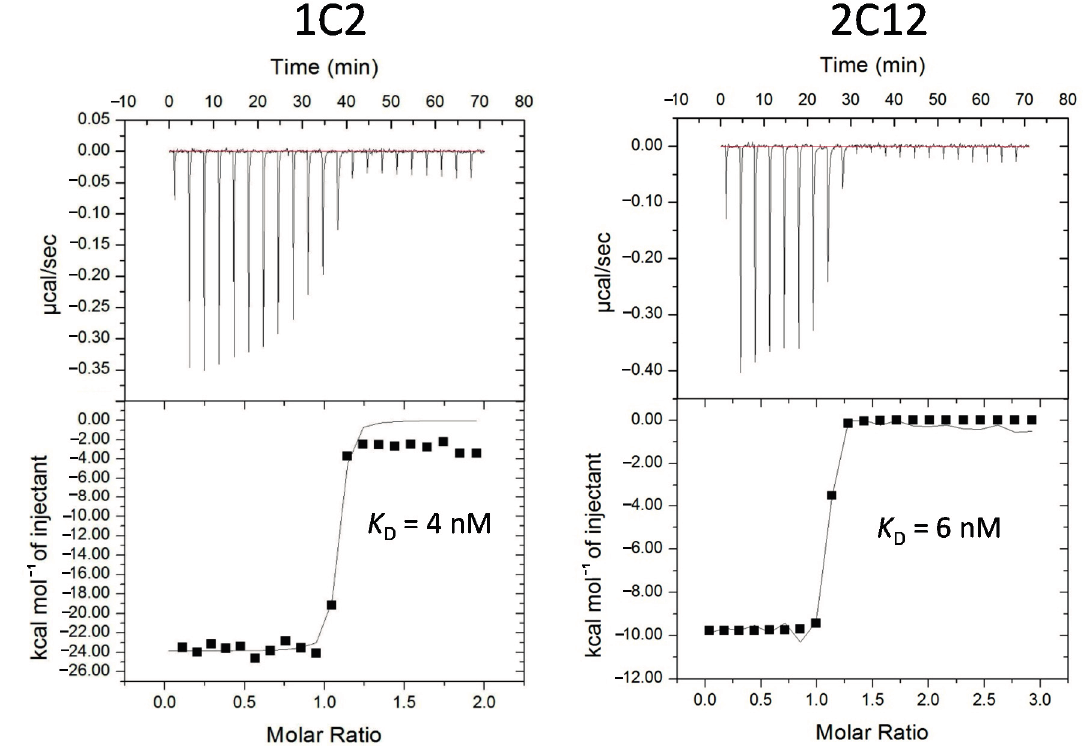
Figure 3. Determination of dissociation constant ( K D ) via isothermal titration calorimetry (ITC). Purified monobodies were injected into the sample cells loaded with their respective targets. Binding events elicited a heat change, which was then graphed as a function of molar ratio. GE Healthcare software (GE Healthcare; Piscataway, NJ, USA) was used to extrapolate the K D value. Both clones exhibited affinities in the single-digit nanomolar